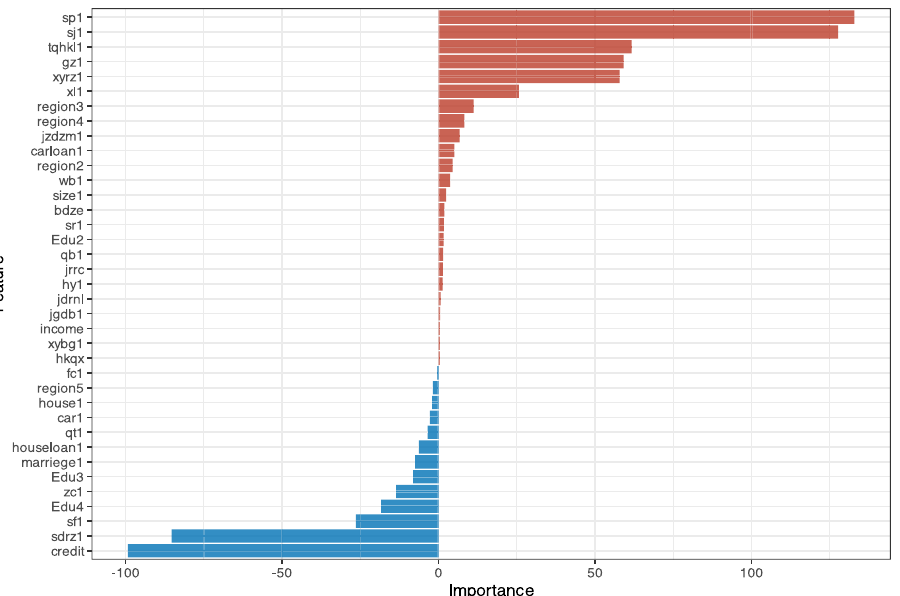
Figure 3. The importance sequence of variables that influence repayment failure (NN).